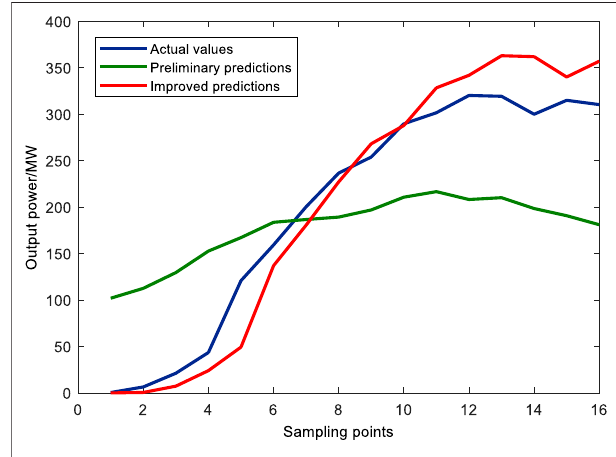
FIGURE 14 | Comparison of results before and after improvement in the morning